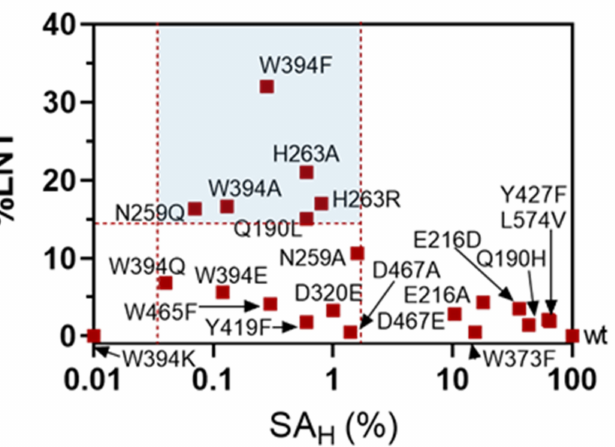
Figure 4. Transglycosylation yields (%LNT) vs. hydrolase activity (SH A ) plot for LnbB mutants at donor subsites. Transglycosylating mutants are those with a SA H between 0.05 and 1.6 % of the wt enzyme.